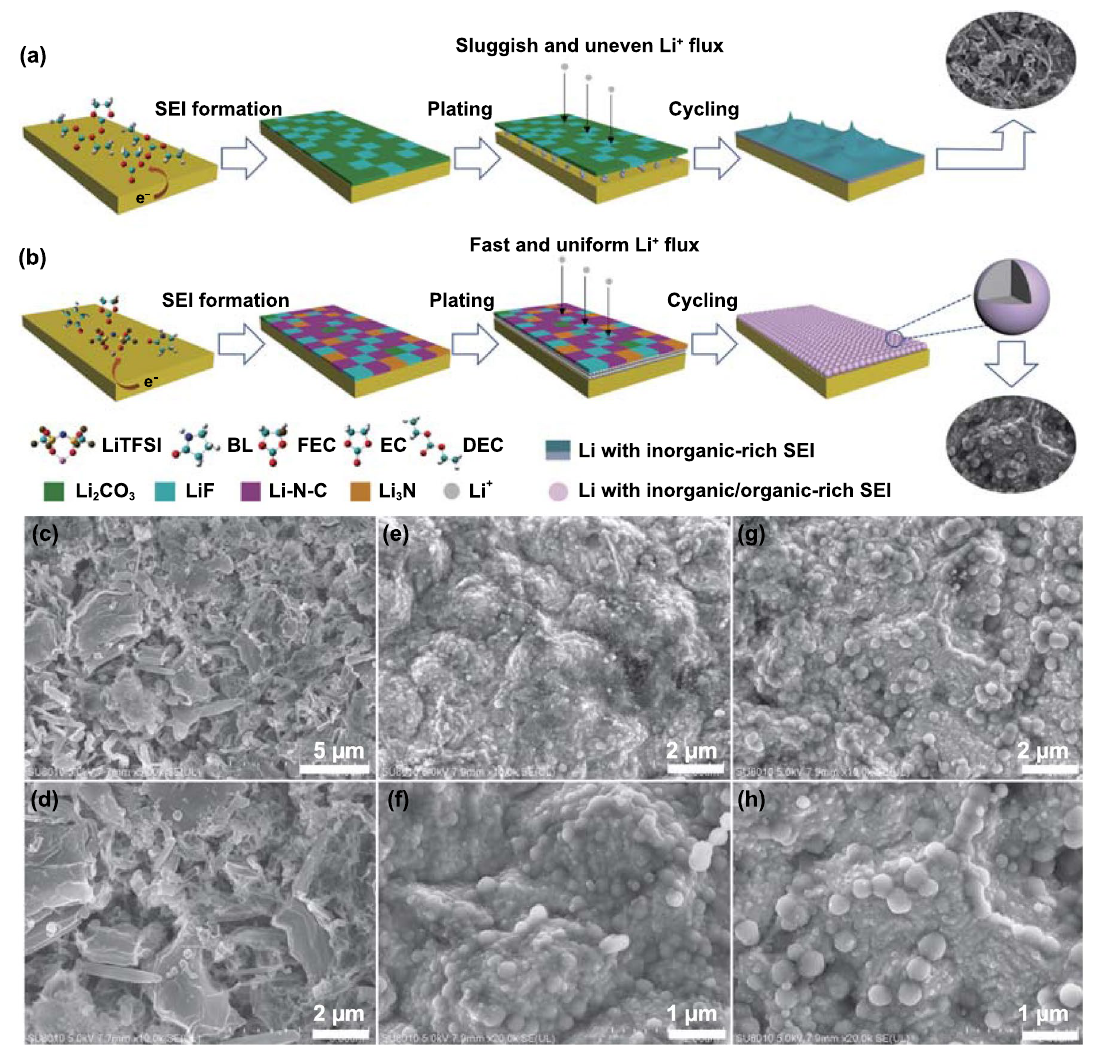
Fig. 3 Schematic illustration of the Li plating behavior with different electrolytes: a 1 M LiPF 6 in EC/DEC and b amide-based electrolytes. SEM images of Li metal after plating on Cu foil at 0.2 mA cm −2 with a capacity of 0.4 mAh cm −2 in different electrolytes: c‑d 1 M LiPF 6 in EC/ DEC (1:1, v/v), e–f LBT-0 and g‑h